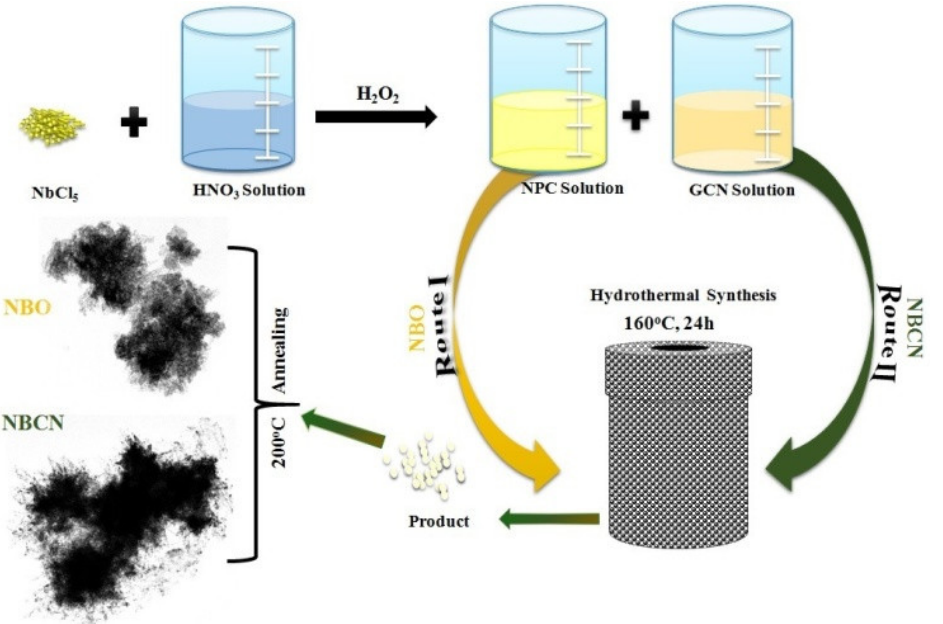
Figure 3. Schematic illustration of the hydrothermal routes followed for Nb 2 O 5 (NBO) and Nb 2 O 5 /g-C 3 N 4 (NBCN) synthesis.